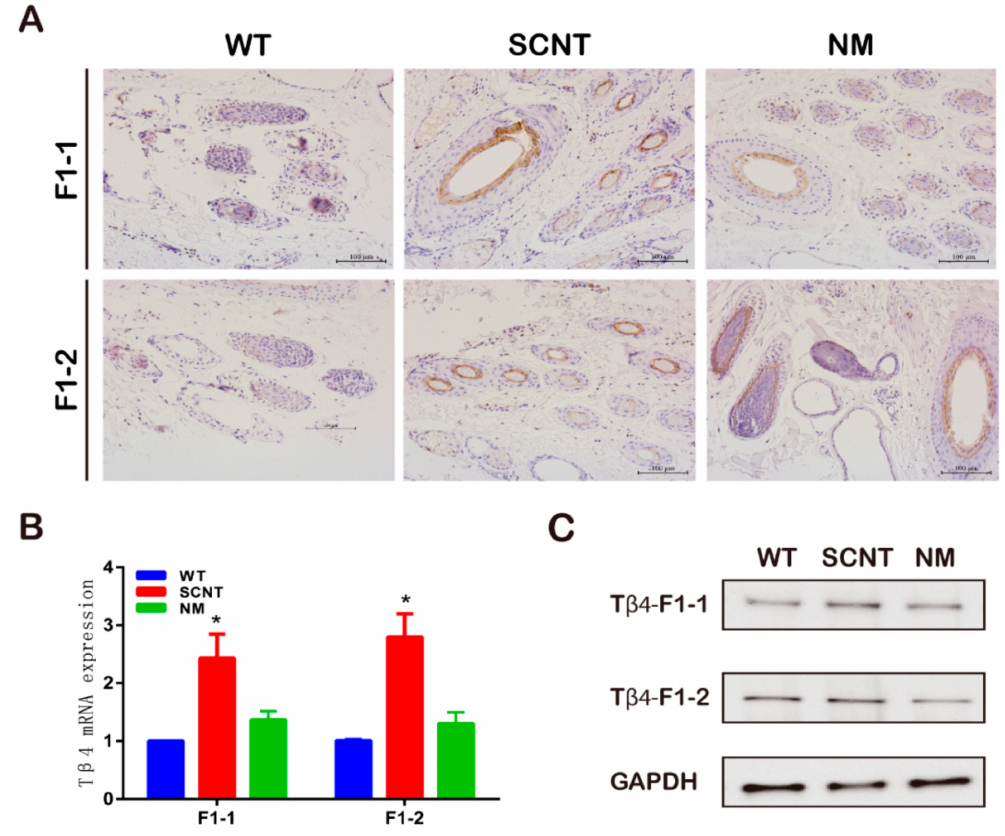
Figure 2. Comparison of T β 4 expression in the hair follicles of T β 4-OE first filial generation. ( A ) Immunohistochemical (IHC) staining of T β 4 expression in representative samples of hair follicles; hair follicles of F1-1 and F1-2 cashmere goats are shown; F1-1, T β 4-OE first filial generation of 2014; F1-2, T β 4-OE first filial generation of 2015 ( B ) qPCR and ( C ) western blot showing T β 4 expression in the skin of F1-1 and F1-2 cashmere goats. Asterisks indicate that the mean expression was significantly di ff erent from the control (*, p < 0.05). Bars indicate the means of three replicates; error bars indicate the standard error of the